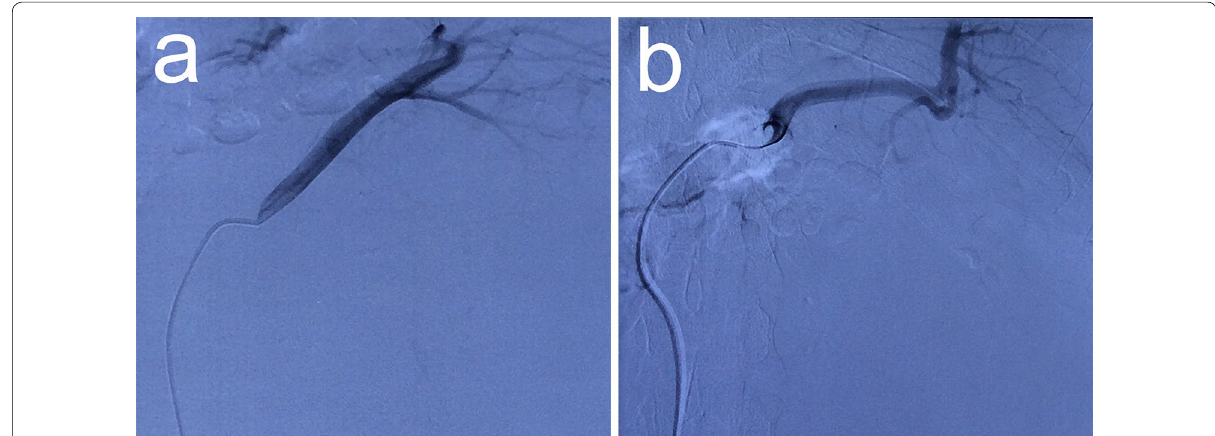
Fig. 2 Preoperative angiography and embolization of the left renal artery. Embolization of the left renal artery was performed on June 30, 2015 to diminish the volume of the mass and to reduce the blood loss during surgery. a The left renal artery before the embolization. b The embolized